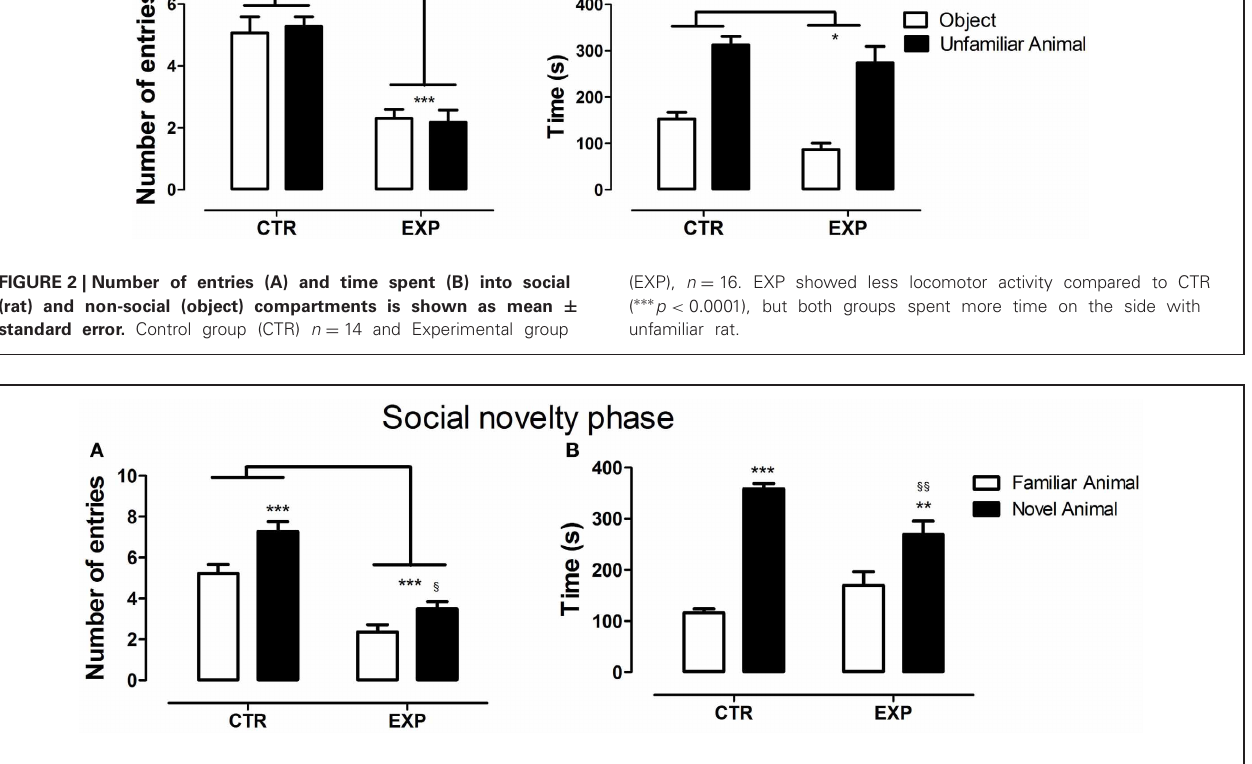
FIGURE 3 | Number of entries (A) and time spent (B) into compartments with familiar and novel rat is shown as mean ± standard error. Control group (CTR) n = 14 and Experimental group (EXP), n = 16. In (A) , less number of entries was noted to the EXP ( ∗∗∗ p < 0 . 0001), but both groups